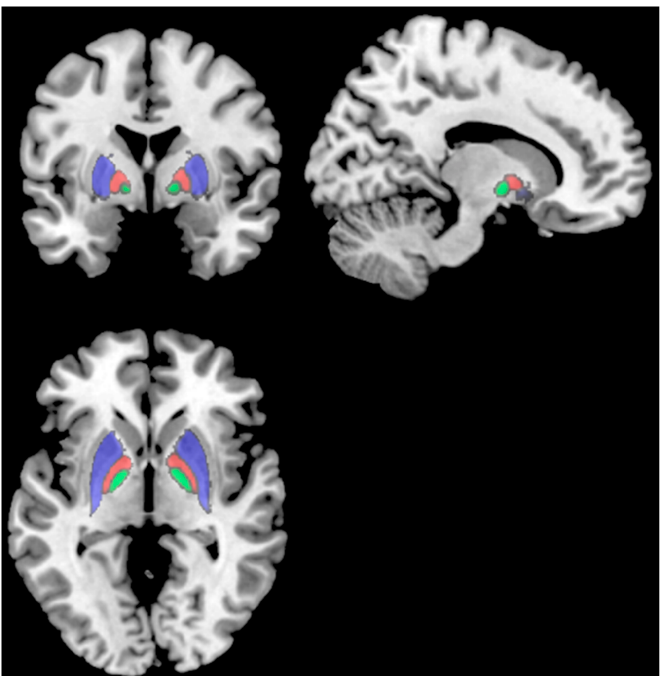
Figure 1. Single subject MNI template [36] T1 MRI showing the putamen (red), pallidum (cyan), and thalamus (green), which all had smaller volumes in subjects >6 months post-infection than subjects <6 months post-infection.